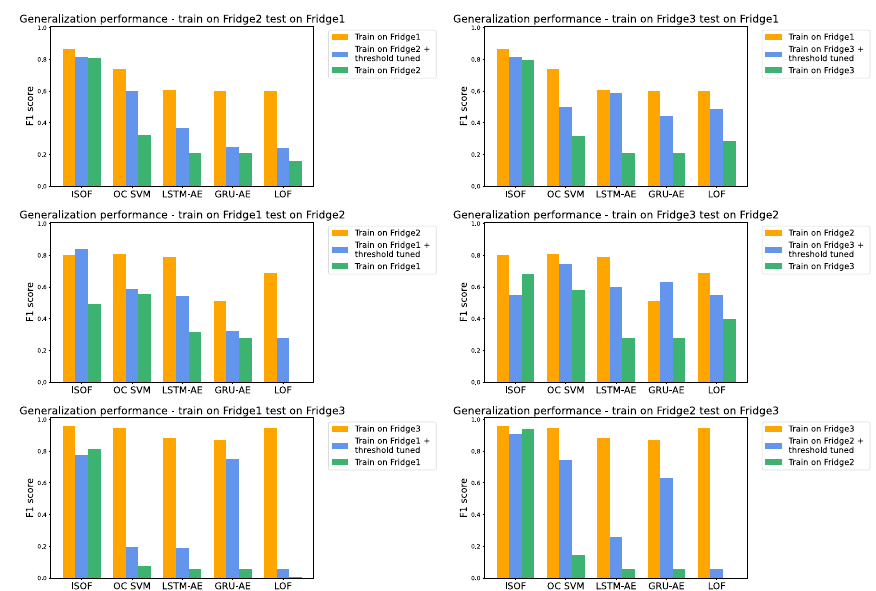
Fig. 10 Comparison of the generalization performance of the top-5 methods. The orange bar represents the baseline F 1 score (i.e., training and testing done on the same dataset), the blue bar denotes the F 1 score achieved by fine tuning the threshold on the validation set of the target appliance, and the green bar shows the performances obtained using the trained algorithm without fine